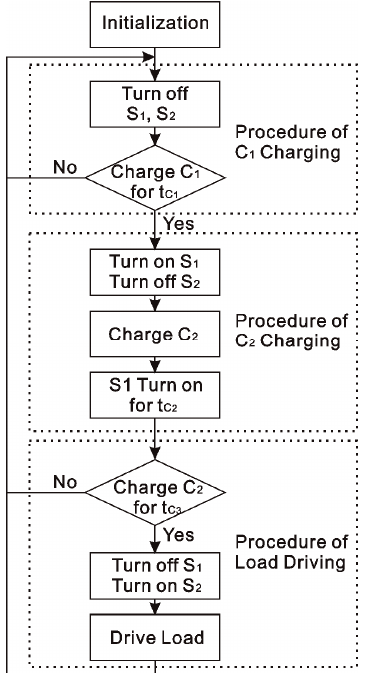
Figure 5. Control strategy for TEGs on